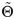
Simulation results.Left: dynamics of the mosquito population density corresponding to the solution of the 2D/1D model with the parameter value Θ* given by maximum-likelihood estimation. Right: dynamics of the mosquito population density given by the 2D model with the maximum-likelihood estimator Θ˜. Values range from 0 (blue) to 1 (carrying capacity, red).